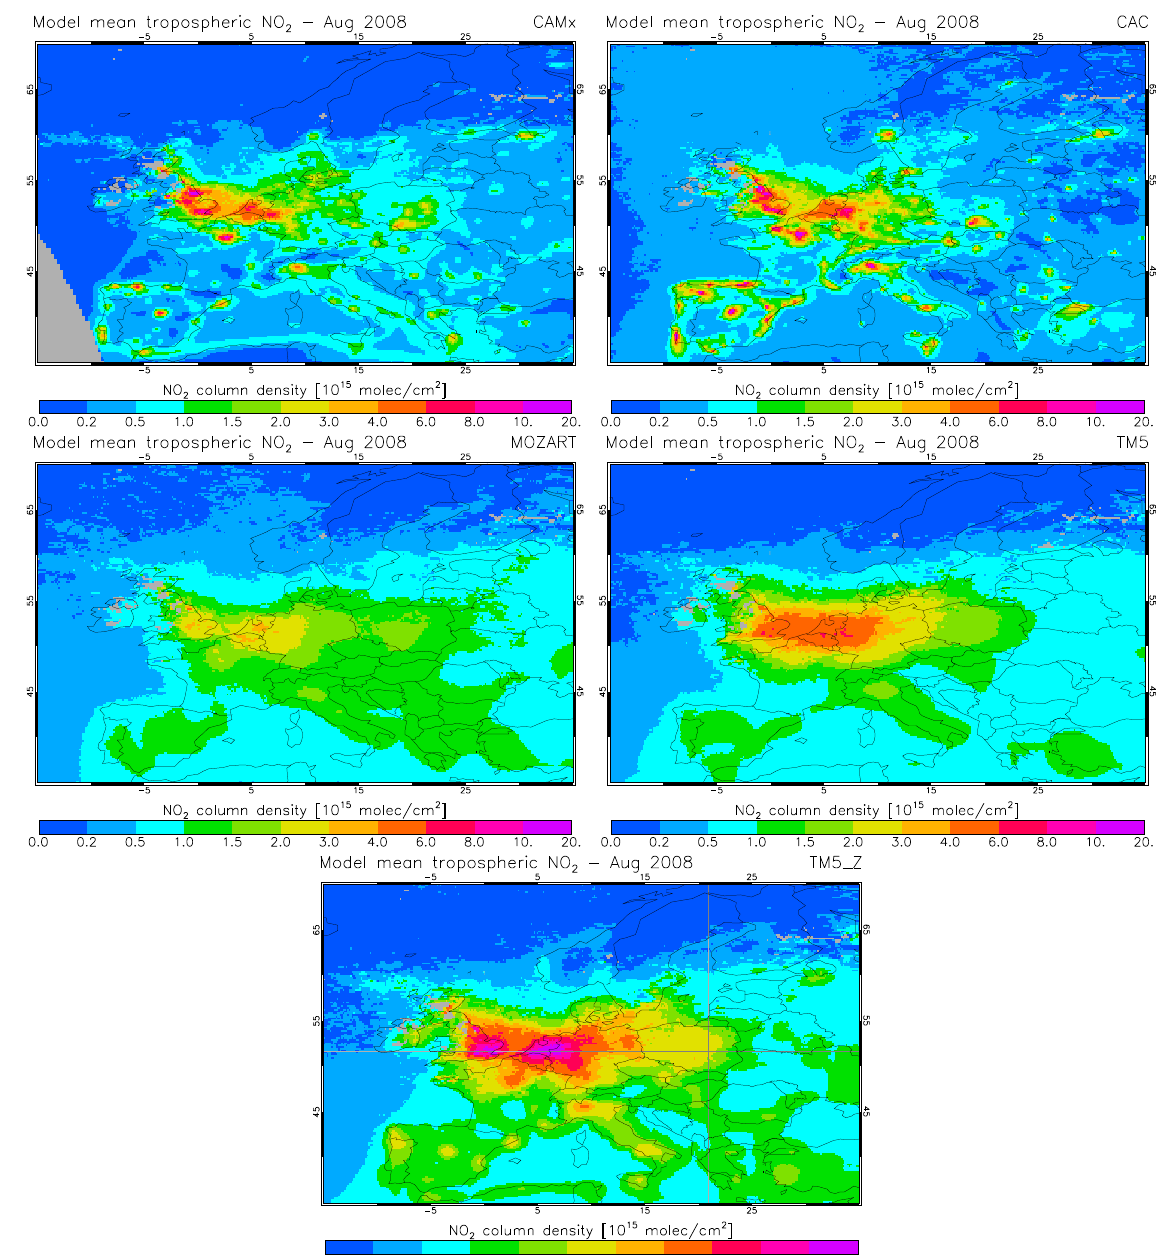
Fig. 5. Mean modeled tropospheric NO 2 columns in August for the contributing regional and global